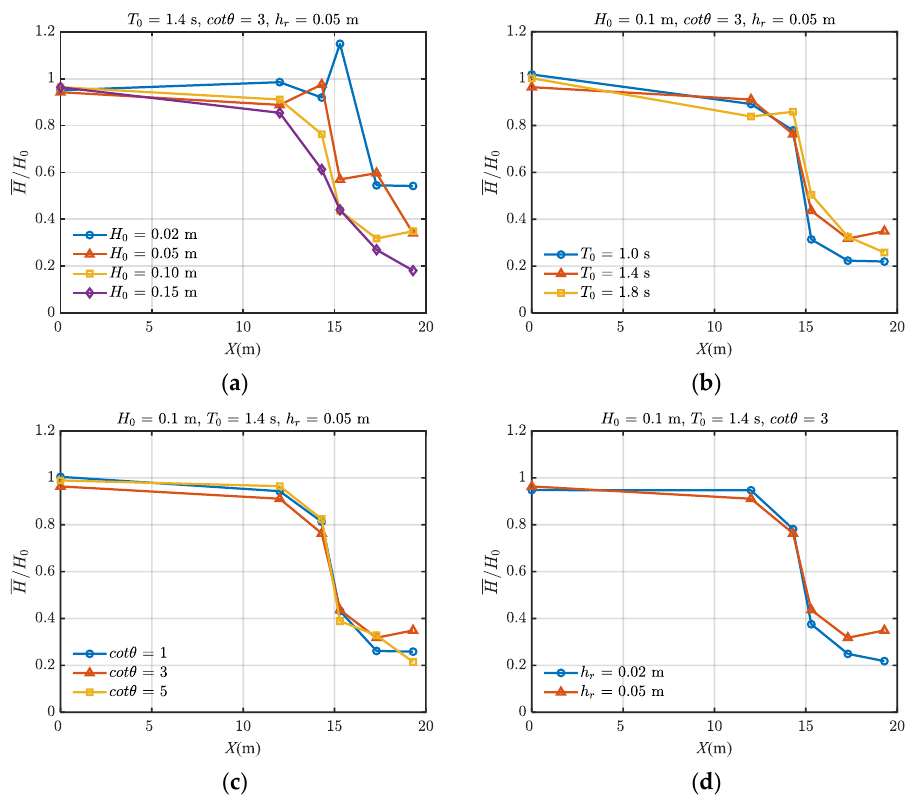
Figure 4. Regular wave height transformation on the reef topography for different cases: ( a ) H 0 ; ( b ) T 0 ; ( c ) cot θ ; ( d ) h r .